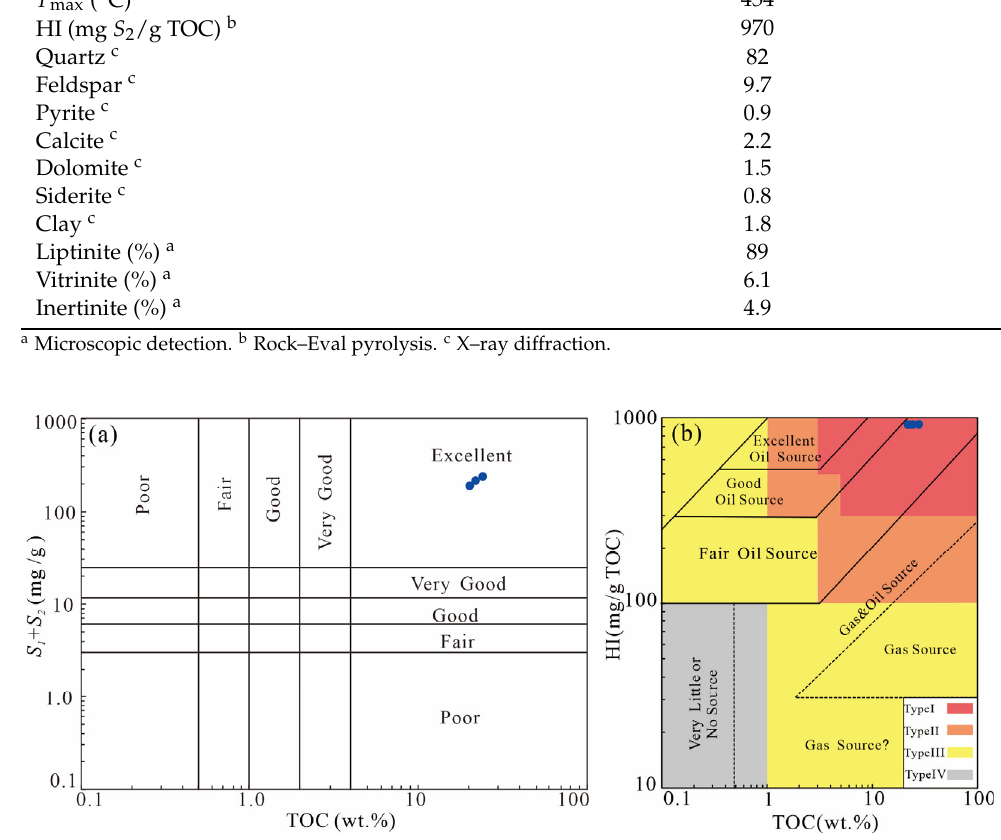
Figure 1. TOC vs. S 1 + S 2 and T max vs. HI showing the organic matter quality ( a ) and type ( b ) of the original unheated sample (( b ) was modi fi ed from Korkmaz et al. [25]).